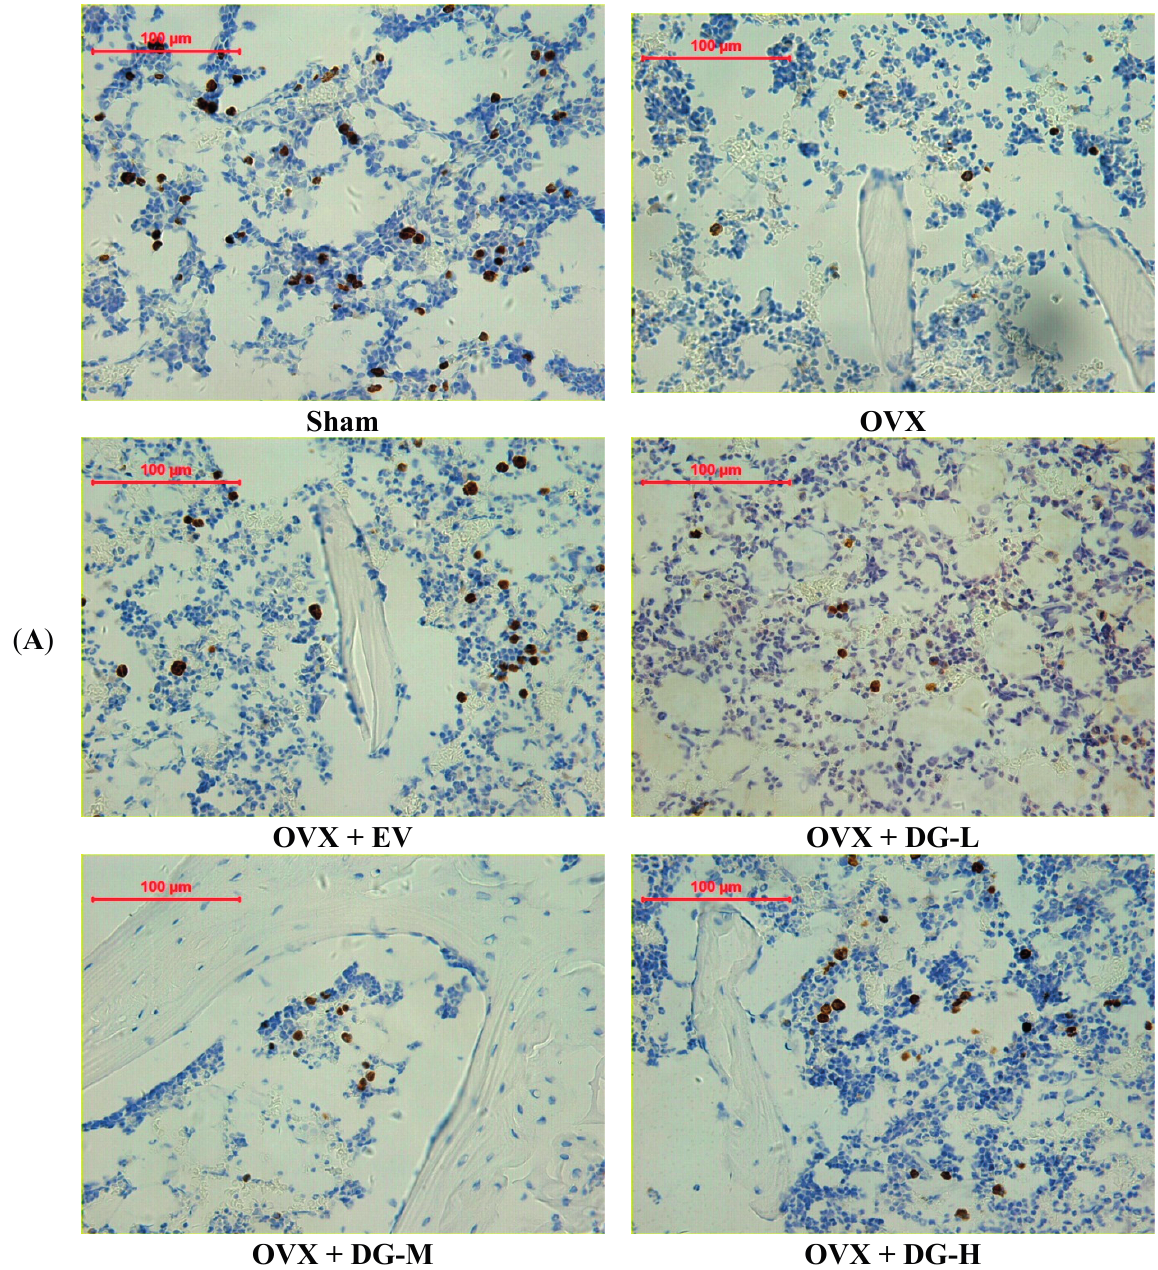
Figure 4. Effects of 12 weeks treatment on expression of OPG and RANKL protein in tibiae of rats. Expression level of OPG and RANKL protein was estimated by immunohistochemical analysis. ( A ) OPG expression; ( B ) RANKL expression; and ( C ) Ratio of RANKL/OPG are shown. In panel ( C ), a, p < 0.01 vs. Sham group; b, p < 0.05 vs.